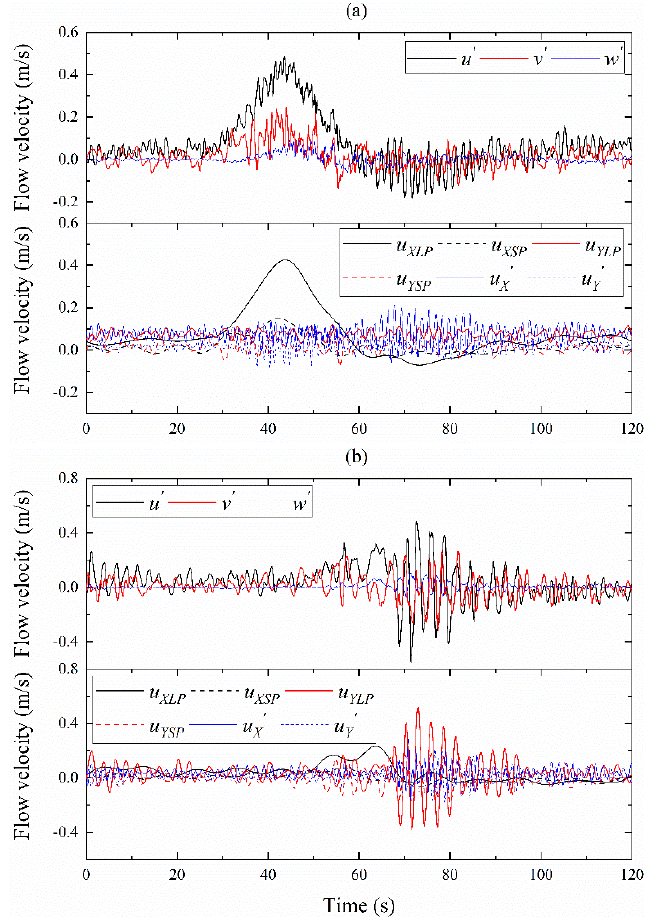
Figure 5. Three-dimensional flow velocity variations and the velocity contributions of the primary wave, secondary wave and the turbulence caused by ( a ) Case No. 1 and ( b ) Case No. 2. If the ship-induced bottom shear stress exceeds the threshold value during the ship passage, the erosion and suspension process will occur. The aforementioned method was used to calculate the ship-induced bottom shear stress using Equations (6), (7) and (10) for the two cases. Figure 6 shows the total bottom shear stress and the contributions of the primary wave, the secondary wave and the turbulence. As shown in Figure 6a, the primary wave contributed the highest magnitude of the bottom shear stress with the maximum τ LP value of 1.938 N / m 2 , and the maximum τ W value caused by Case No. 1 was 4.013 N / m 2 . For Case No. 2, the bottom shear stress increased within the secondary wave packets with the maximum τ W value of 8.542 N / m 2 . The secondary wave-induced and turbulence-induced shear stresses contributed most of the bottom shear stress with the maximum τ SP and (cid:2028) (cid:3021) values of 6.839 N/m 2 and 6.333 N/m 2 , respectively.